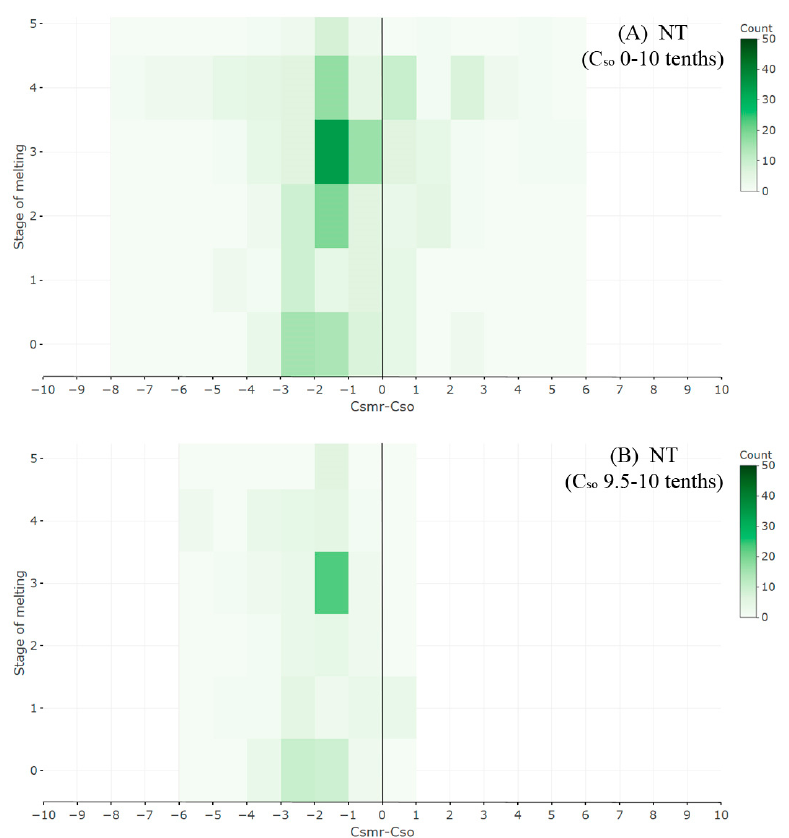
Figure 14. ( A , B ) The di ff erence between NT (25 km) and ship observations depending on ice melt stage. The horizontal axis denotes the di ff erence C smr –C so (tenths), the vertical axis the melt stage (points). Color intensity indicates the C smr –C so count for particular melt